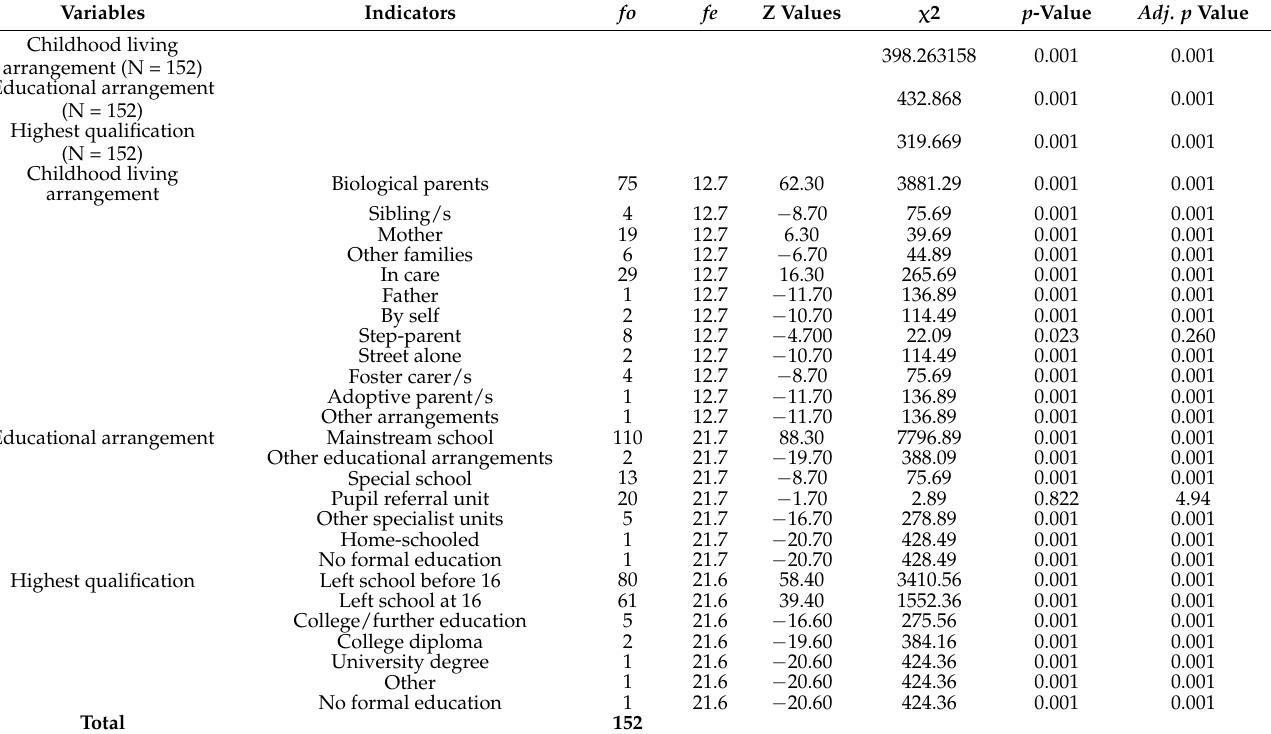
Table 4. Observed frequencies of indicators of homeless people’s social status compared with those expected if the null hypothesis is